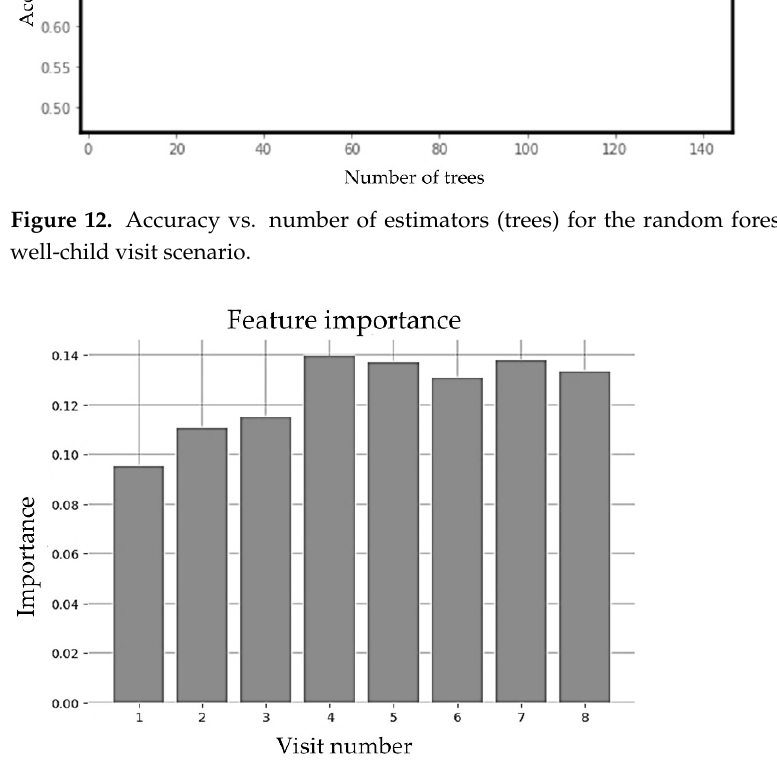
Figure 13. Feature importance of random forest for early visits (until 2 years).